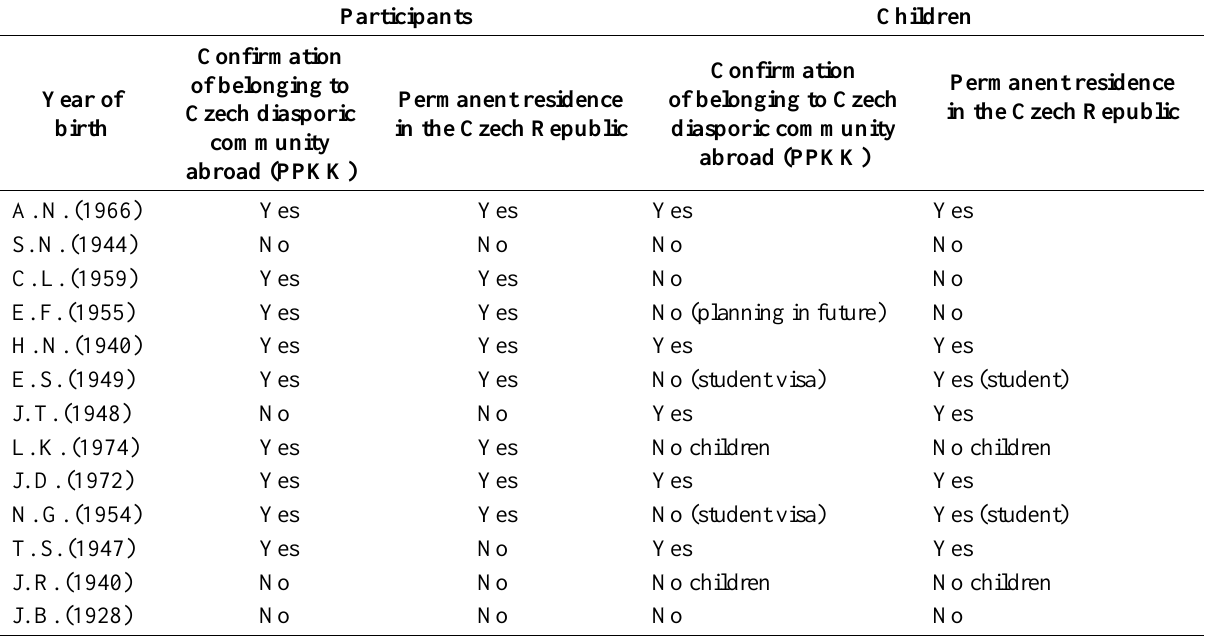
Table 3. Confirmation of belonging to Czech diasporic community abroad and permanent residency